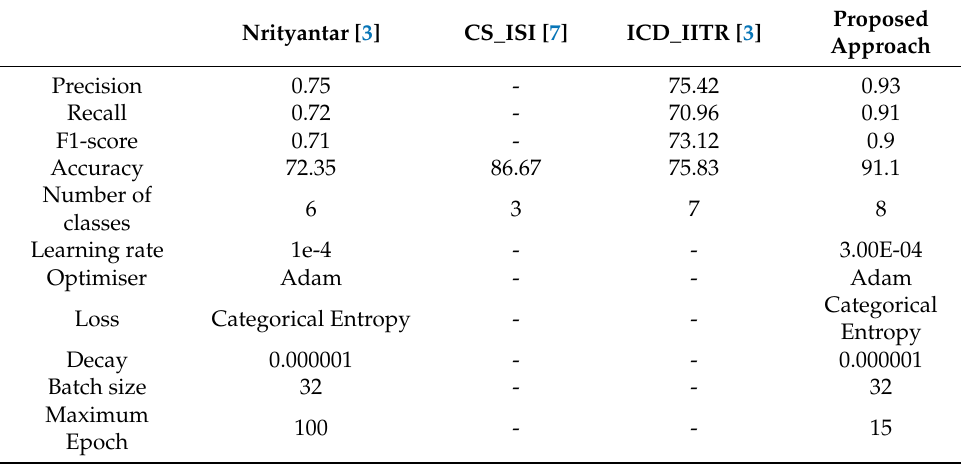
Table 3. Existing literature and proposed